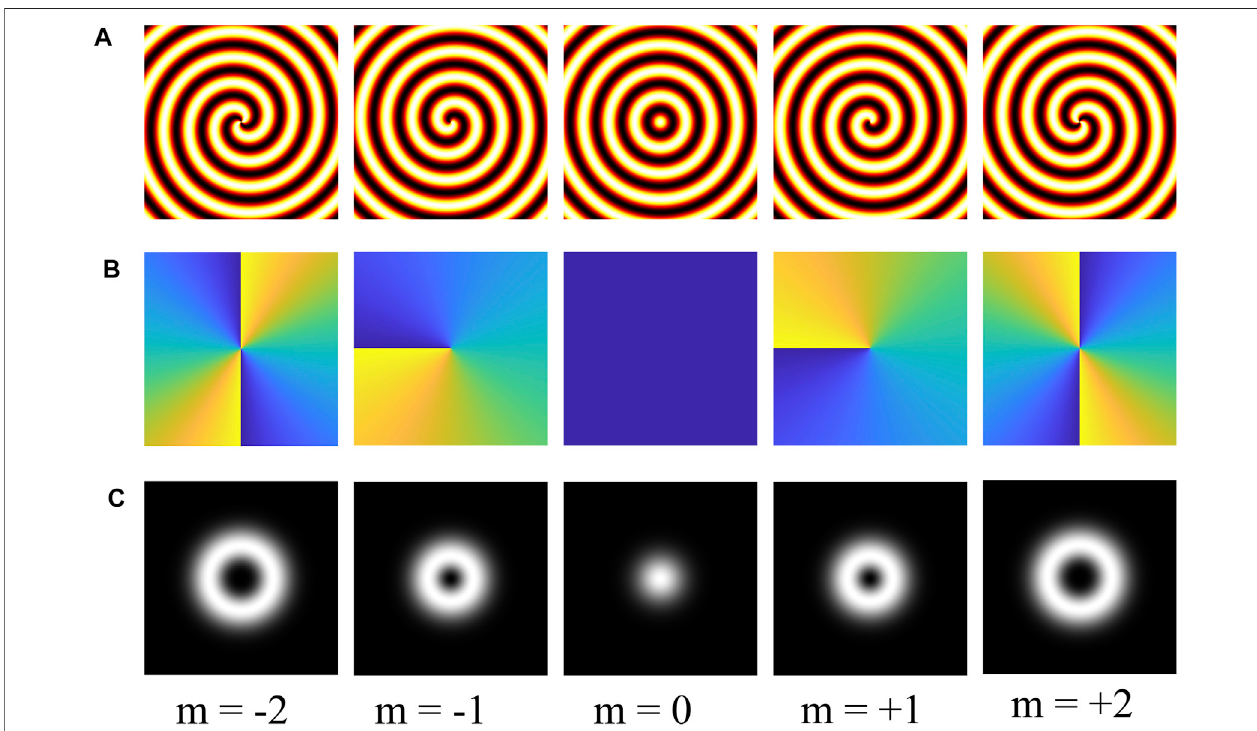
FIGURE 1 | (A) Illustration of corkscrew wavefronts of a vortex beam (m = 2, 1, 0, − 1, and − 2, respectively); (B) the corresponding phase information of the vortex beam withthe topological order m =2, 1, 0, − 1, and − 2,respectively; (C) thecorrespondingintensitydistribution pro fi le ofthe vortex beam with topological order m= 2, 1, 0, − 1, and −